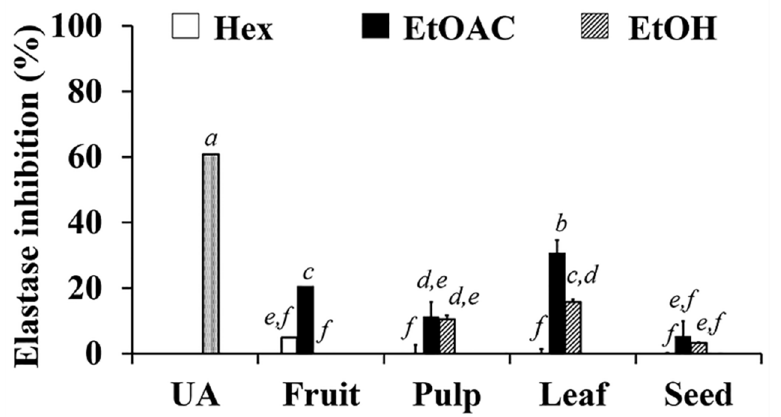
Figure 5. Inhibition against elastase of 1 mg/mL ursolic acid (UA) and various parts of C. carandas sequentially extracted using n -hexane (Hex), ethyl acetate (EtOAc), and 95% ethanol (EtOH), respec- tively. DMSO was used as a vehicle control. The letter a , b , c , d , e , and f denote significant difference among different C. carandas extracts ( p < 0.05) after analyzed by one-way ANOVA followed by Tukey’s test.